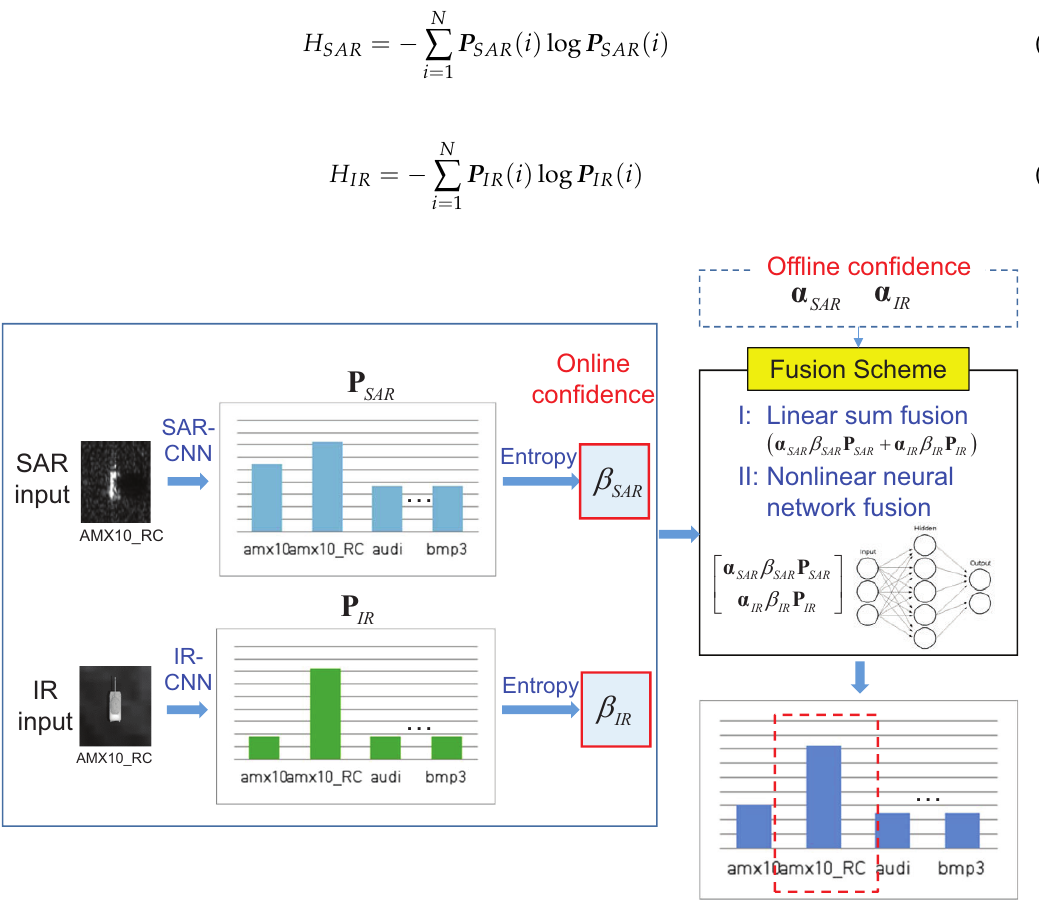
Figure 8. Offline confidence and online confidence-based SAR and IR fusion